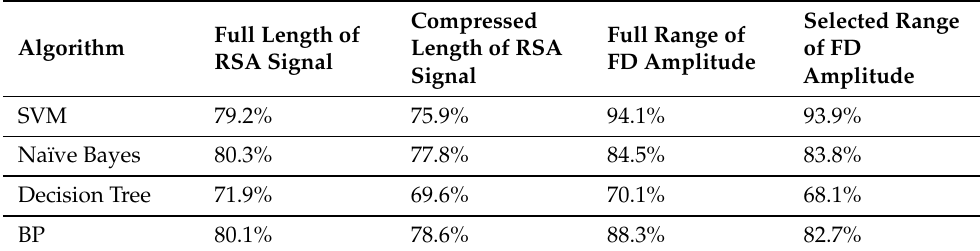
Table 9. Accuracy performance of different classifiers of air voids defect using different source of training